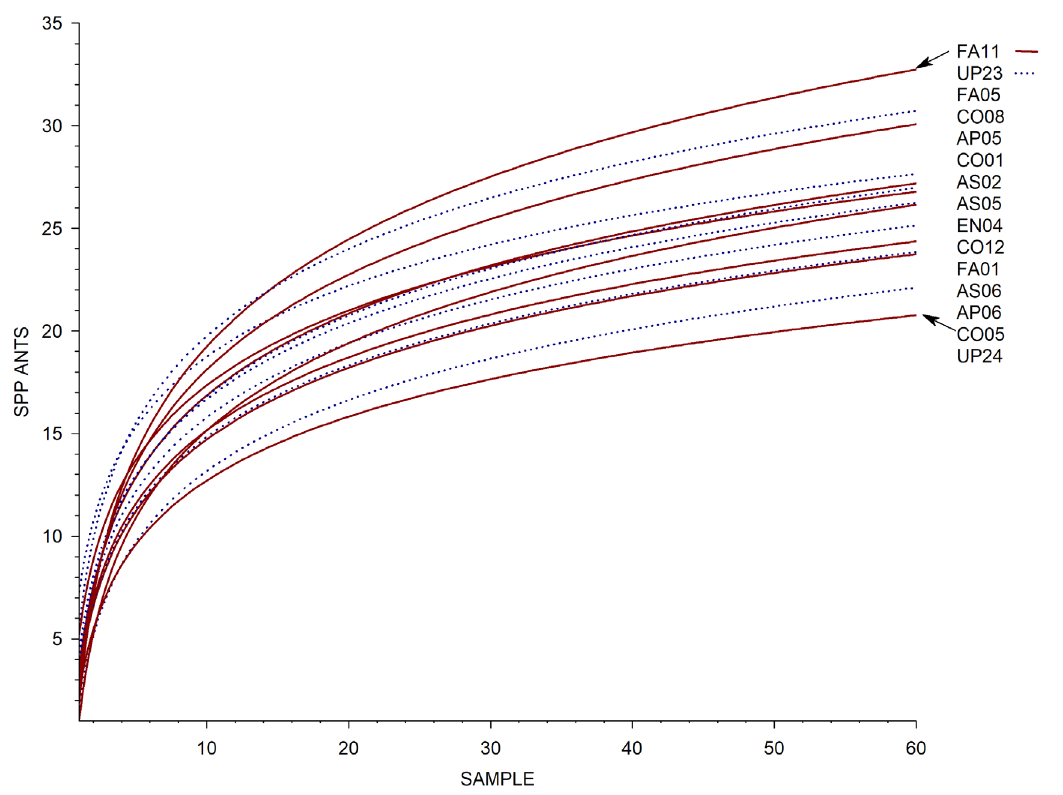
Fig 2 . Rarefaction curves of ants for each farm, with the abundance of workers per species and trap. The curves are alternatively drawn in solid and dotted lines for a better